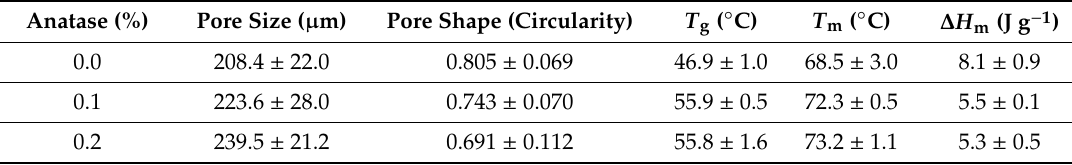
Figure 1. Microstructure of the scaffolds prepared with different anatase concentrations. The images were obtained with SEM ( a – c ). The red spots show the titanium (Ti) mapping with EDS ( d – f ), indicating a homogeneous distribution of anatase (TiO 2 ) nanoparticles. Bar scale 300 µ m. Table 1. Microstructure by SEM and thermal characterization by DSC of the sca ff olds prepared with di ff erent anatase